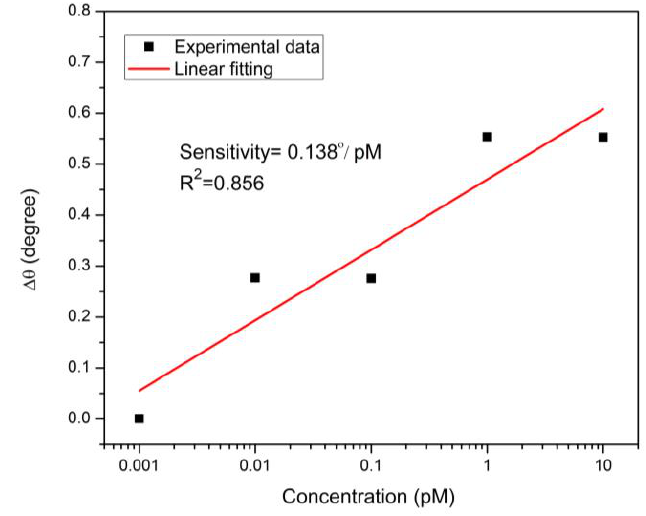
Figure 6. Linear fitting for CQD sensor film exposed to various concentrations of DA. Table 2. Comparison of the proposed SPR sensor with other DA sensors using CQDs in terms of limit of detection and response